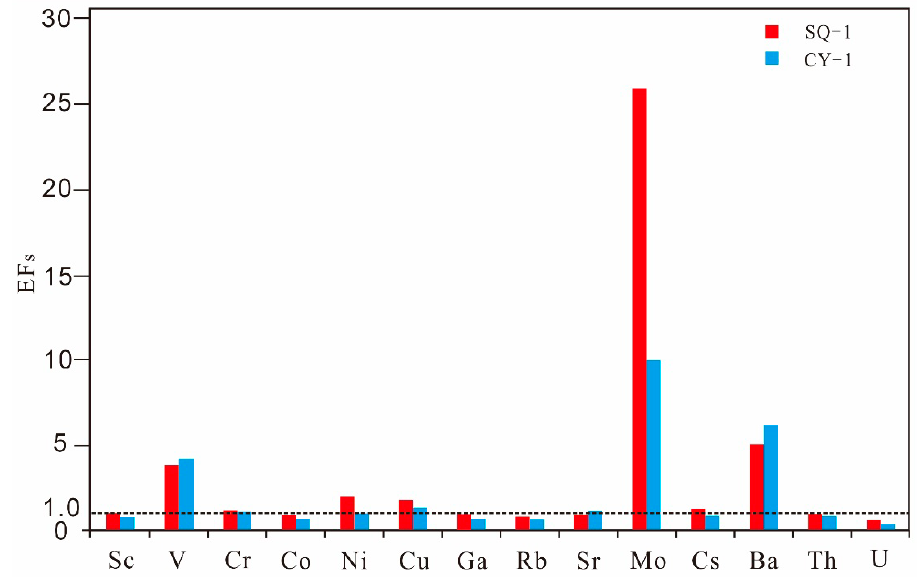
Figure 5. Enrichment factors (EFs) diagram of the selected trace elements of samples from SQ-1 and CY-1.